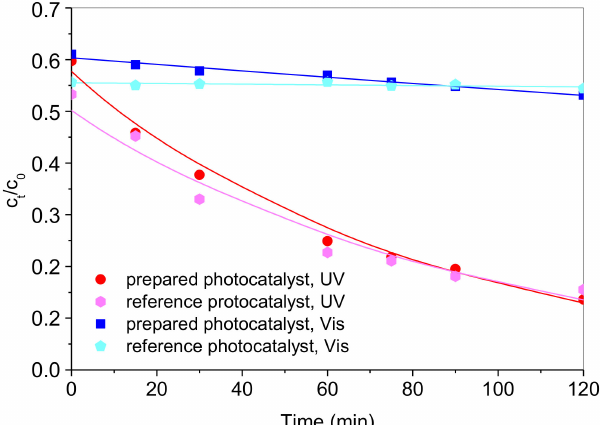
Figure 9. The kinetics of RV2 dye degradation over prepared photocatalyst with Ag nanoparticles and reference sample without Ag [24] under UV-A and visible light (initial RV2 concentration of 50 ppm, catalyst concentration of 1 g/L, T = 22 ◦ C, pH 6.5, RV2 absorbance measured at 550 nm). The lines correspond to the pseudo-first-order kinetic model for RV2 degradation over respective photocatalysts and irradiation